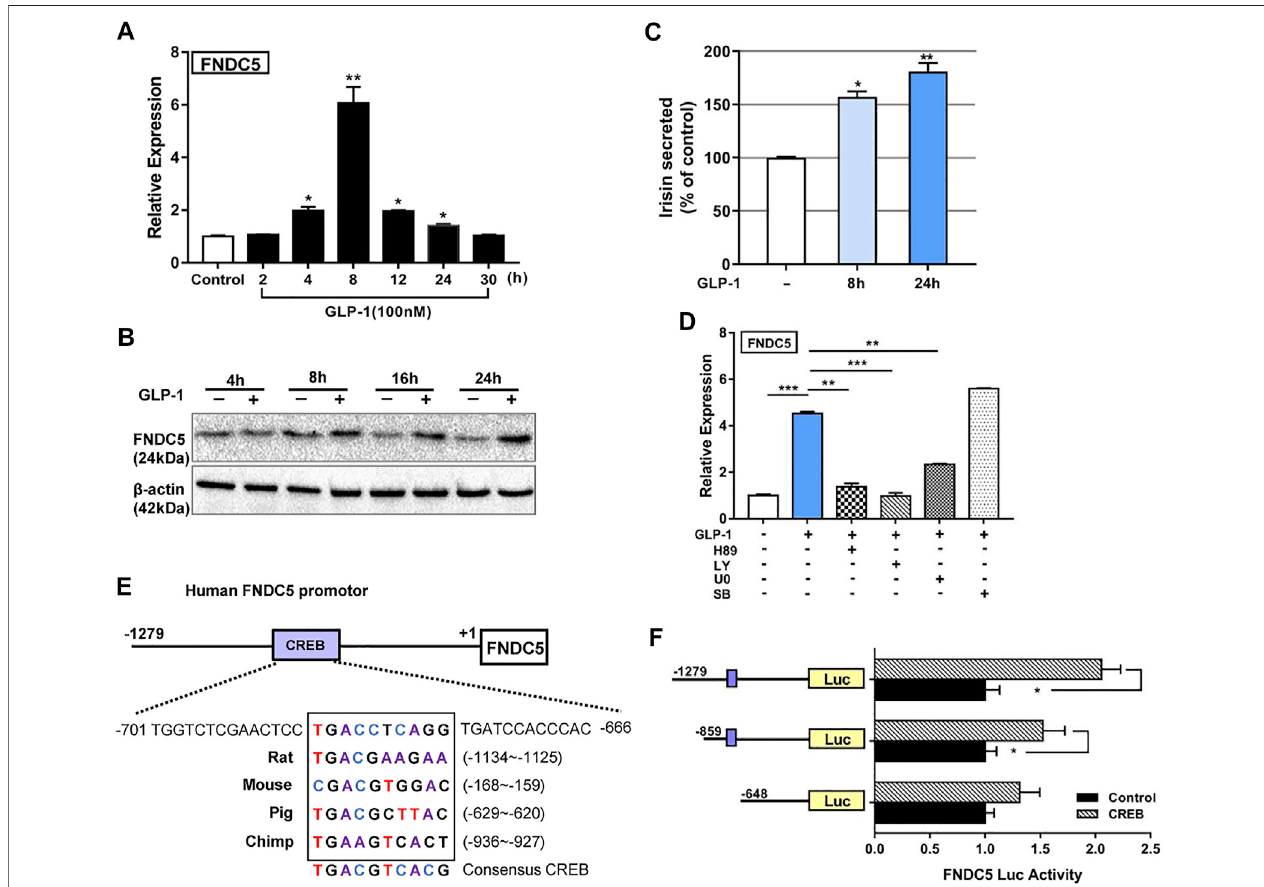
FIGURE1| GLP-1upregulatesFNDC5geneexpressioninhumanpancreatic β -cellsandmousepancreasandbraintissue.TheexpressionlevelsofFNDC5mRNA (A) and protein (B) in GLP-1-treated (100 nM) β Lox5 cells were analyzed at indicated time points. (C) Secreted irisin in the culture medium of GLP-1-treated (100 nM) β Lox5 cells was measured by using ELISA. The level in untreated controls was set as 100% for normalization. (D) The expression level of FNDC5 mRNA in β Lox5 cells. Cells were treated with GLP-1 (100 nM) and selected inhibitors for 8 h before RT-qPCR analysis. (E) A conserved CREB binding site in the FNDC5 gene promoter from multiple mammalian species. The prediction was performed with the online Genomatix Suite Collection. The box-enclosed regions highlight the predicted core CREB binding motif, and the consensus sequence is shown at the bottom. (F) CREB regulates the expression of luciferase (Luc) under the control of the FNDC5 promoter.HEK293cellsweretransfectedwitha CREB expressionplasmid(0.5 μ g)andaplasmidwithluciferaseunderthecontrolofthreedifferentlengthsofthe FNDC5 promoter (1 μ g). Values are mean ± SEM. * p < 0.05, ** p < 0.01 and *** p < 0.001.